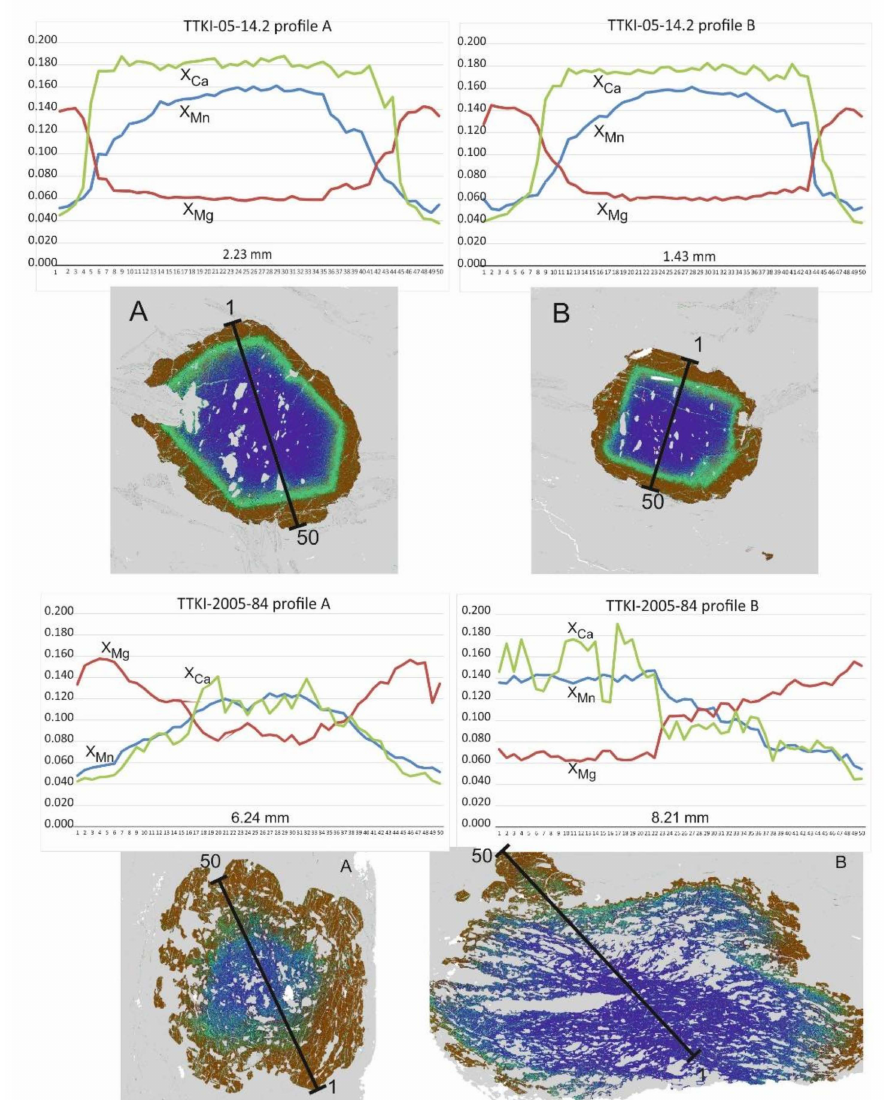
Figure 7. Zoning profiles with QEMSCAN images of the two textural types of garnet grains. Samples TTKI-2005-14.2 ( type A ) and TTKI-2005-84 ( type B ). 50 spots were analysed in every profile. The images of the whole thin sections are shown in Supplementary Materials, Figure